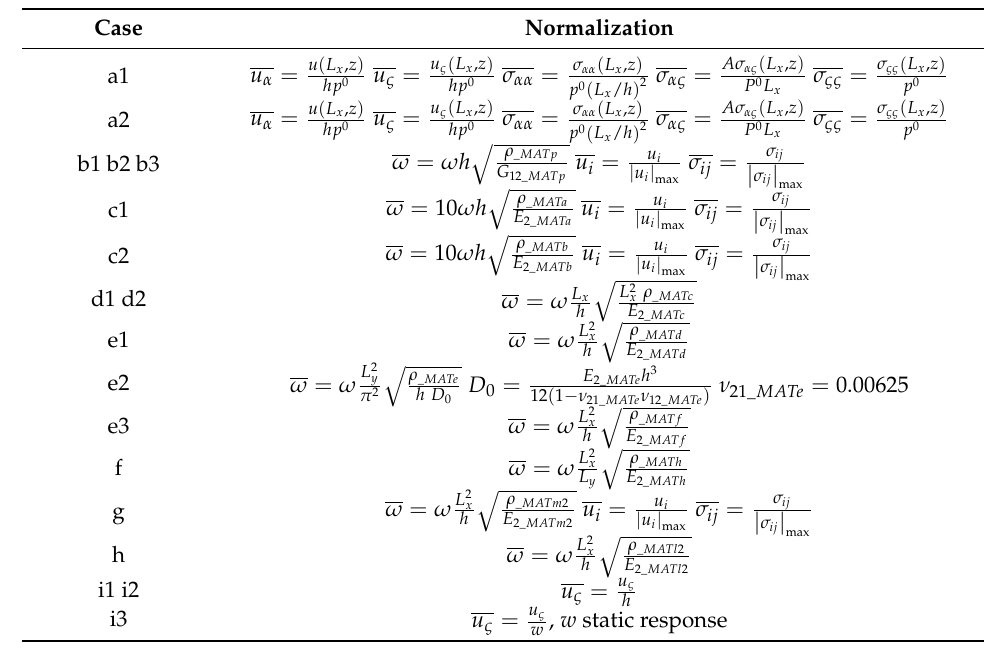
Table 5. Normalization of displacements, stresses and